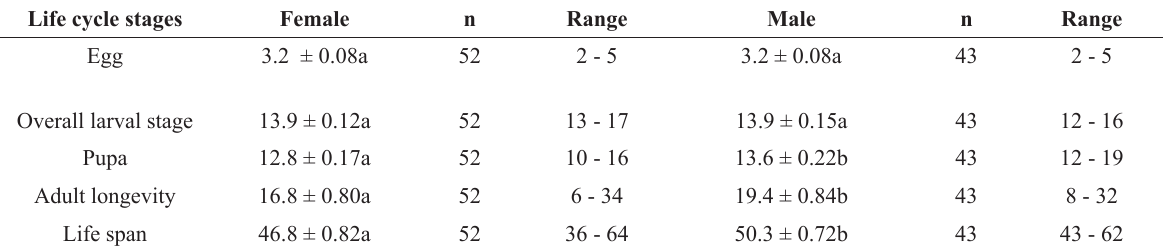
Duration in days (mean ± SE) of egg, larval and pupal stages, adult longevity and life span for both sexes of Helicoverpa gelotopoeon .